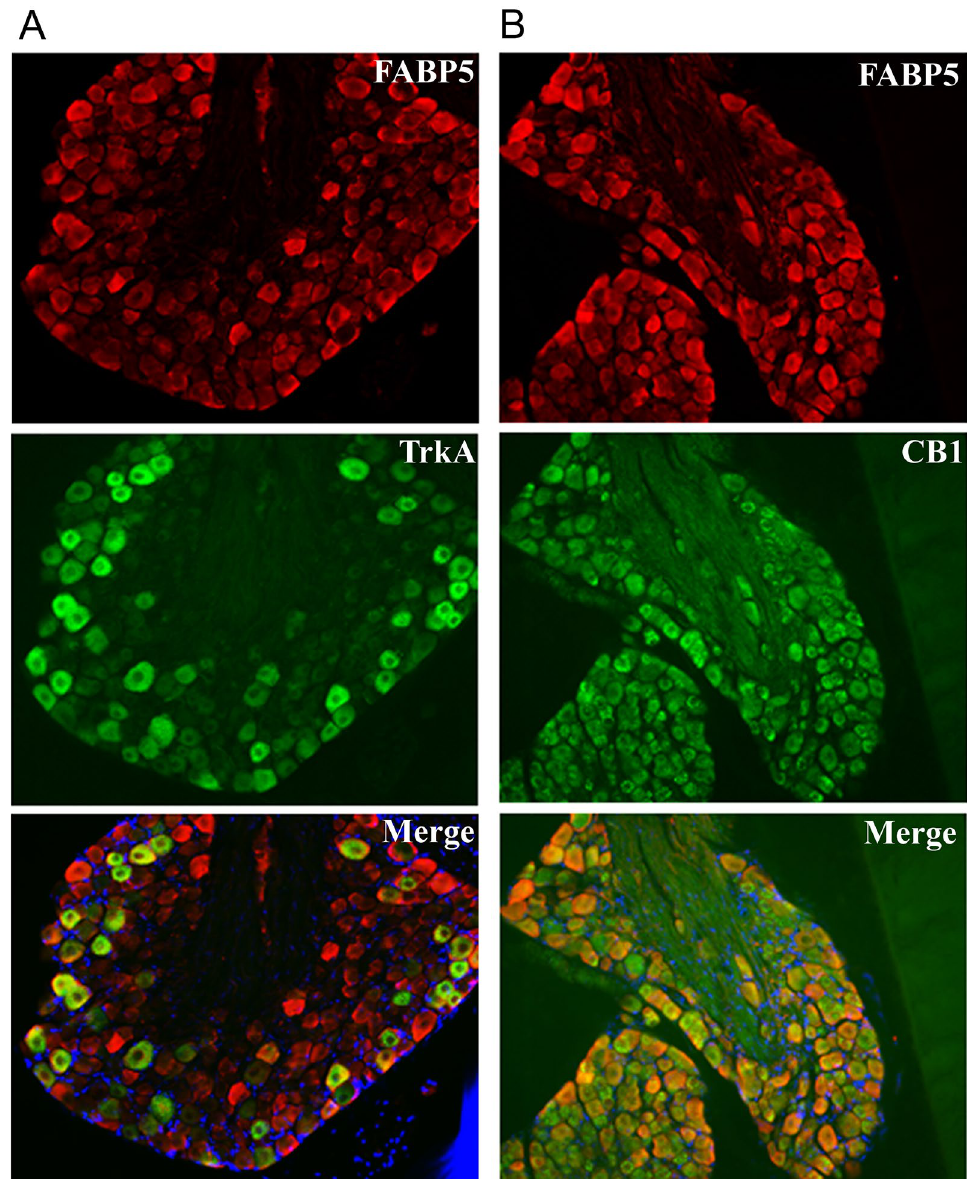
Figure 5. Co-expression of FABP5 with ( A ) TrkA and ( B ) CB1 in DRG neurons. Representative images of FABP5, CB1, and TrkA distribution in L4-L5 DRGs. DAPI is shown in